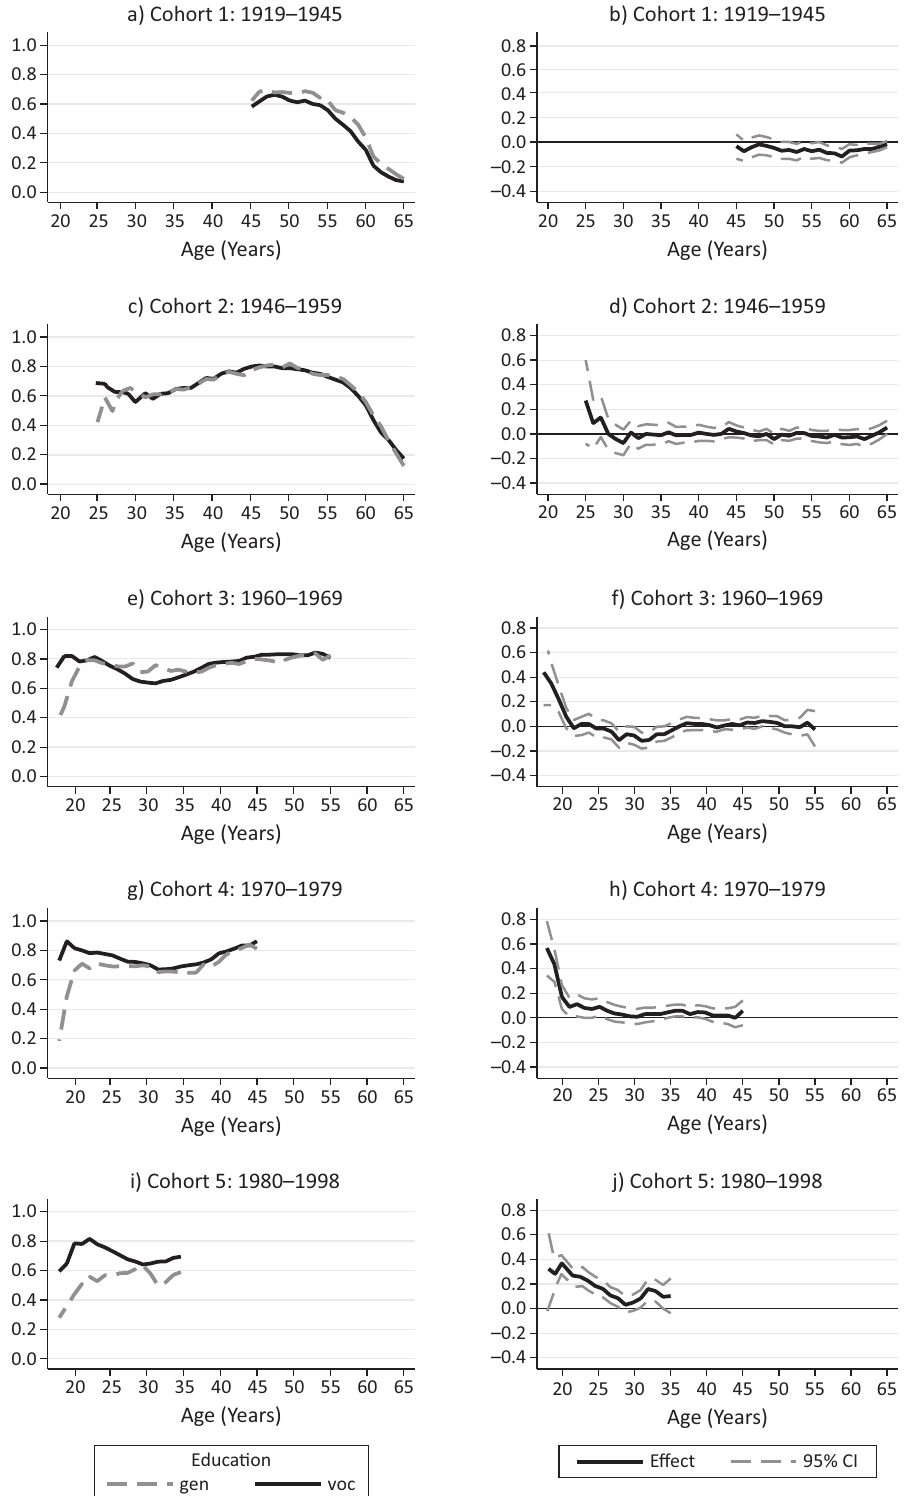
Figure 4. Cohort variation in employment opportunity over the life course: General versus vocational education (women). Notes: Conditional profile plots (left) and conditional effect plots (right) estimated by cohort-specific non-parametric state probability models of vocational and general education on employment probabilities of women. Control variables include period effects, German nationality, parental educational background, residence in West Germany, and educational level. N persons (cohort 1) = 3,365; N person-years (cohort 1) = 29,210; N persons (cohort 2) = 4,870; N person-years